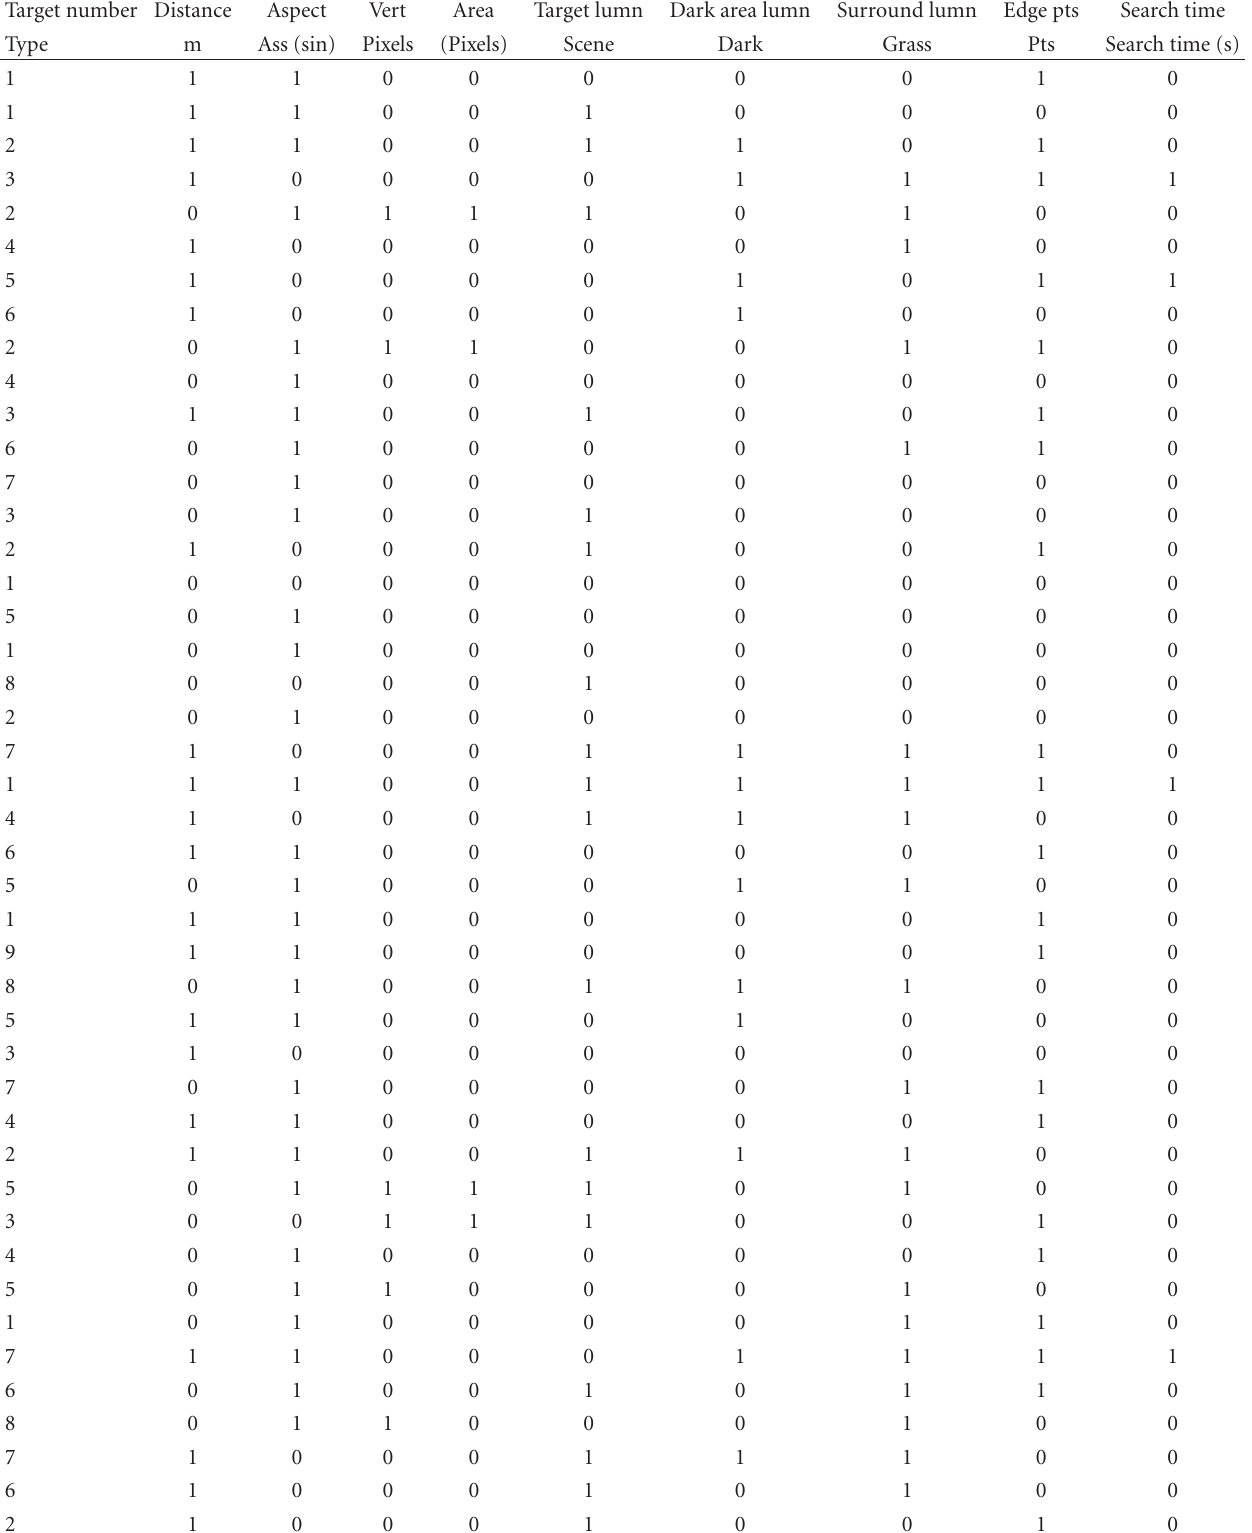
Table 10: Sample data from [5] reduced to